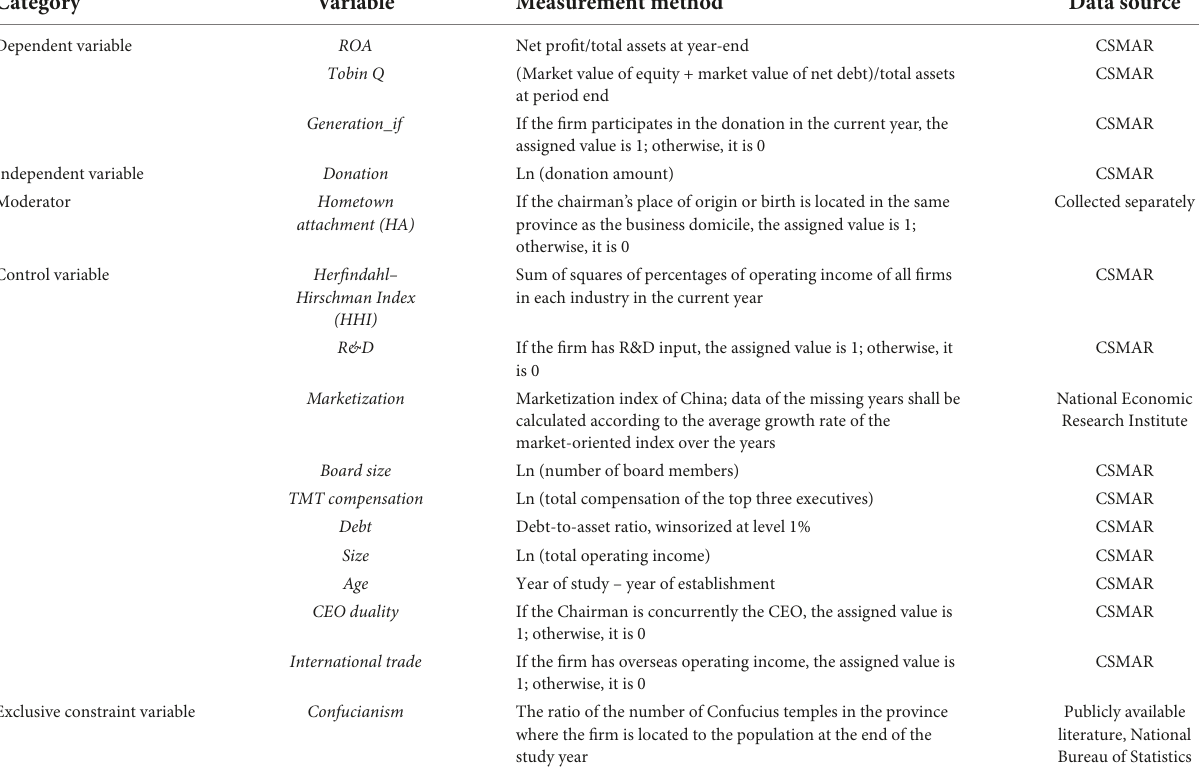
TABLE 2 Variable